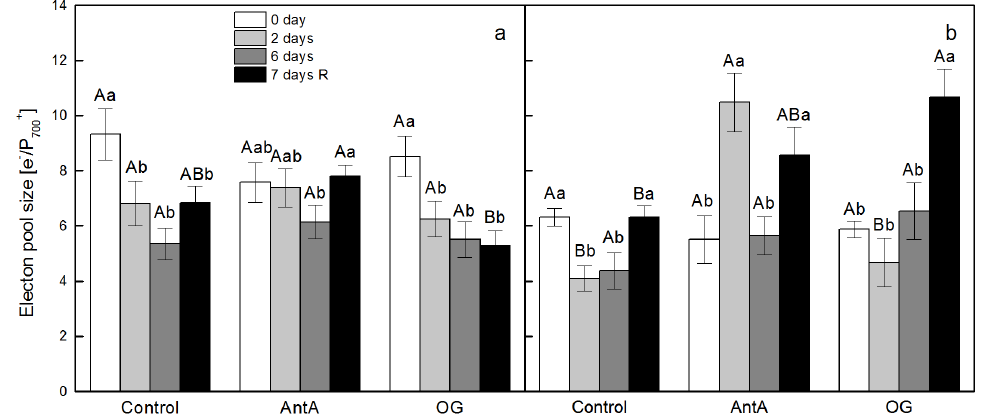
Figure 4. Effects of electron transport inhibitors - 10 µ M antimycin A (AntA) or 20 µ M octyl gallate (OG) - on the size of the intersystem pool of electrons that can be donated to P 700+ in leaf discs of Arabidopsis thaliana , wt ( a ) and lut2 ( b ). Leaf discs were infiltrated for 2 h on distilled water (Control) or on distilled water containing AntA or OG. Leaf discs were cut from non-treated plants, after 2 or 6 days of treatment with low temperature and high light intensity or after a recovery period (7 days R). Results presented are mean values ± standard error (SE) from three parallel samples of two independent experiments ( n = 6). Different letters indicate significant differences for the respective parameters at p < 0.05 (uppercase for the different treatments (Control, AntA and OG) on a certain day; lowercase for the certain treatment at a different time periods (0 day, 2 days, 6 days and 7 days R).